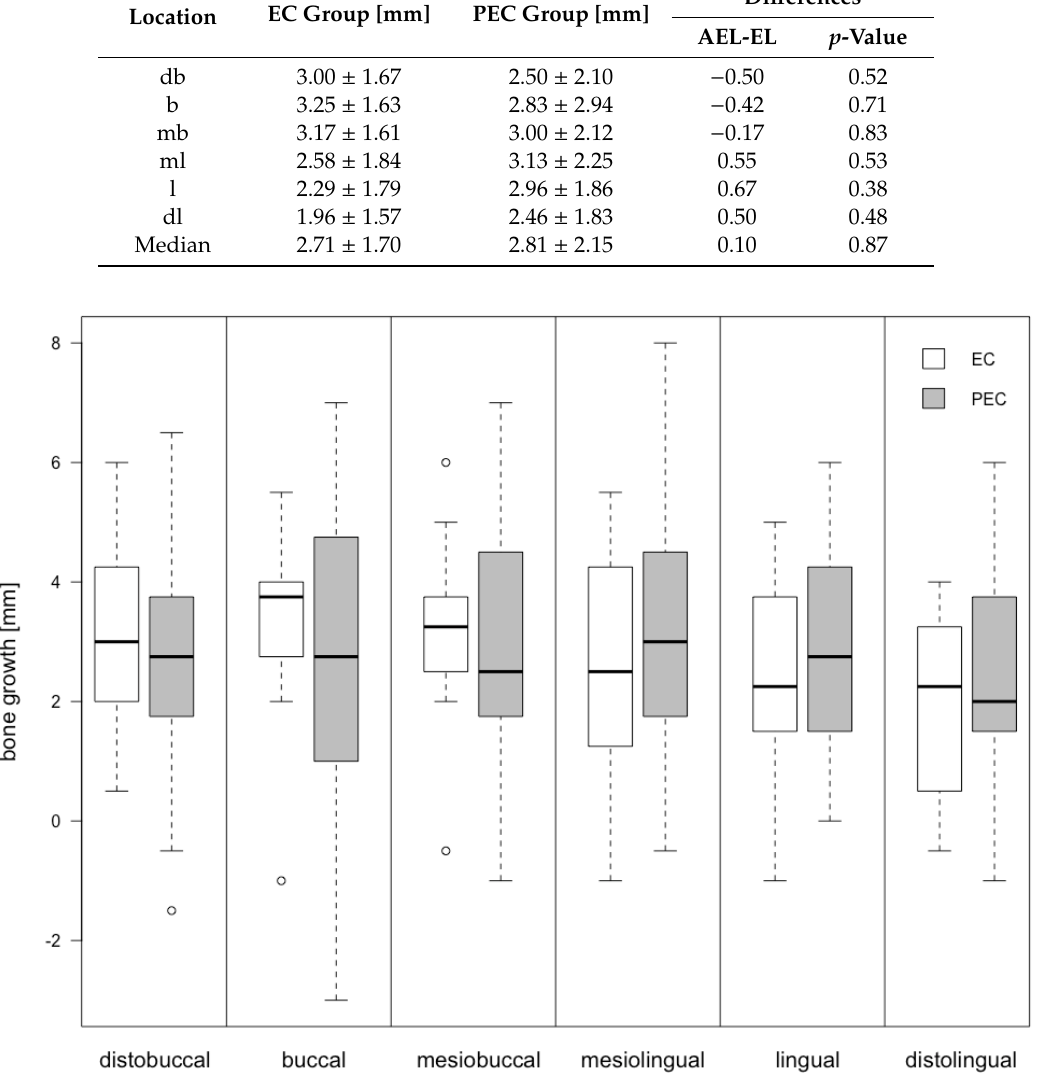
Figure 5. Boxplot indicating the distribution of the assessment points in EC and PEC. 228